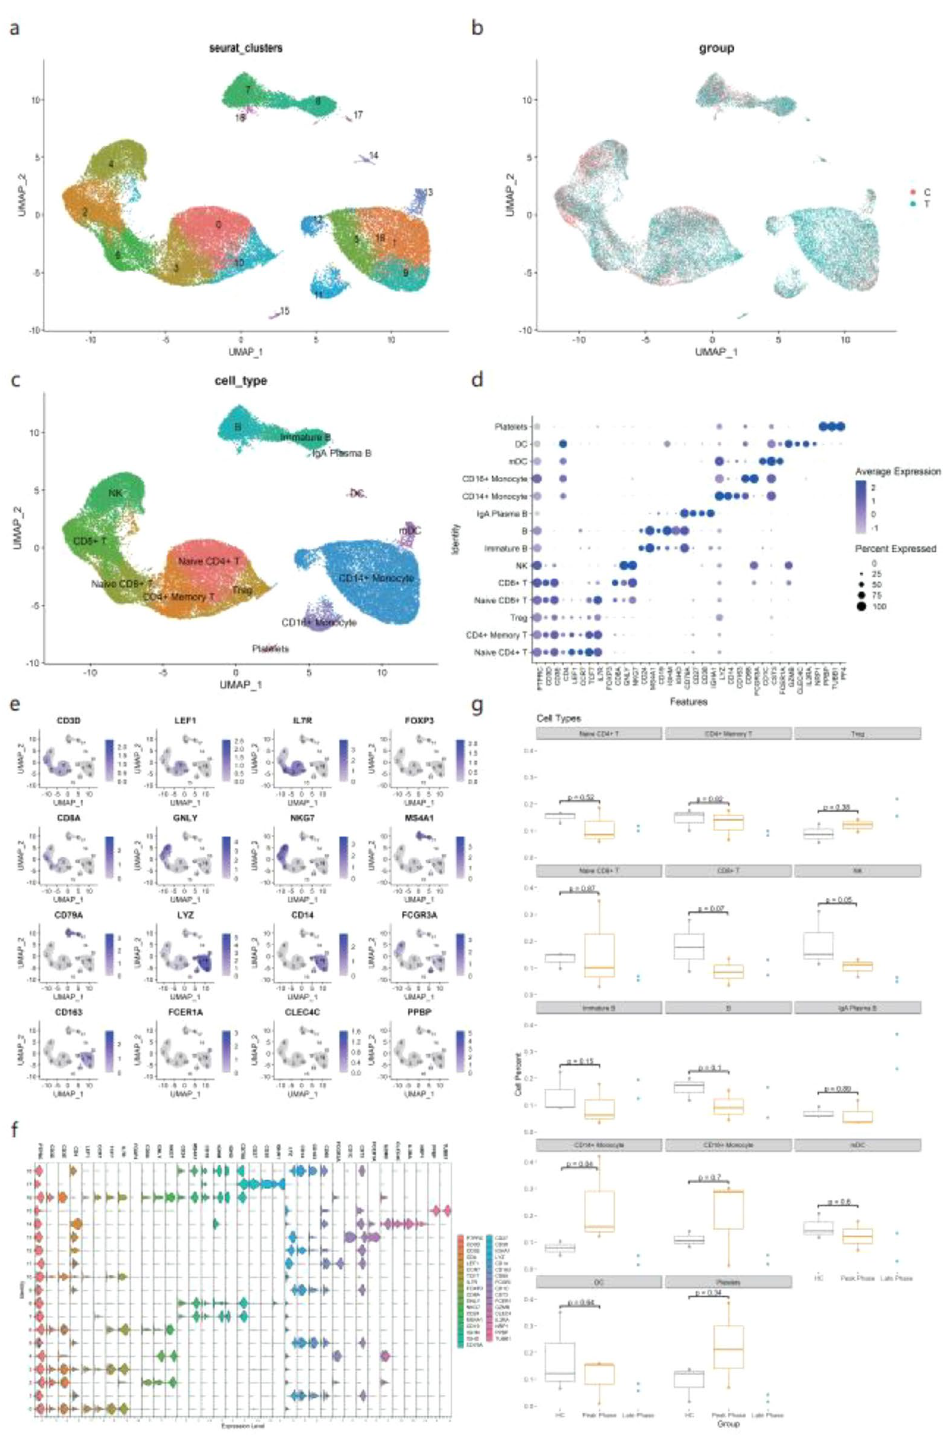
Figure 2. Landscape of PBMCs (peripheral blood mononuclear cells) from HC (healthy control) and AIDP (acute inflammatory demyelinating polyneuropathy) patients. ( a ) A 2D UMAP (uniform manifold approximation and projection) visualization of the identified HC and AIDP patients PBMCs clusters. ( b ) The distribution of HC and AIDP patients derived cells in UMAP, the color of cells are divided by group (C: HC, T: AIDP patients). ( c ) Cell annotation of HC and AIDP patients PBMCs and visualization by UMAP. ( d ) A dot plot shows the expression of reference marker genes in annotated celltypes, the plot color scale represents the average expression and the size scale represents the expression percent of selected marker gene transcripts in each cell type. ( e ) Distribution of classic PBMCs marker genes in each cell of all clusters, the color scale represents expression levels. ( f ) A violin plot is used to display the expression levels of representative PBMCs marker genes across clusters. ( g ) Boxplots show proportions of each cell type in HC and AIDP patients. The x axis correspond to the disease course of each patient. n = 3, n = 3 and n = 2 biologically independent samples for HC, AIDP peak stage and AIDP late stage, respectively. Wilcoxon rank-sum test is used to calculate two-sided P values between HC and AIDP peak stage group, shown all P values. Horizontal lines represent median values, with whiskers extending to the farthest data point within a maximum of 1.5 × interquartile